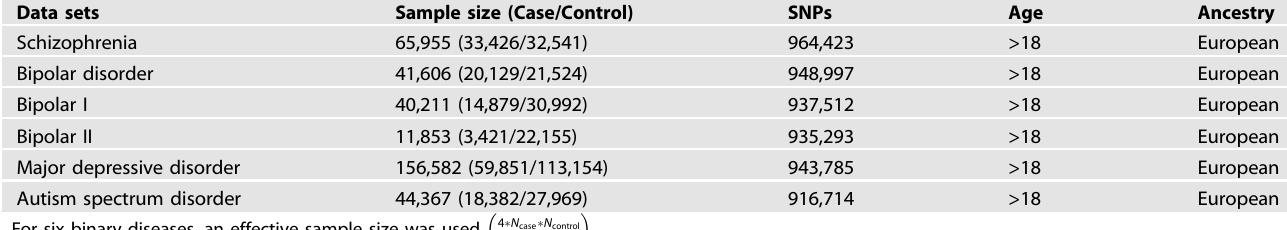
Table 1. Basic characteristics of six summary statistics for psychiatric disorders in this study. Data sets